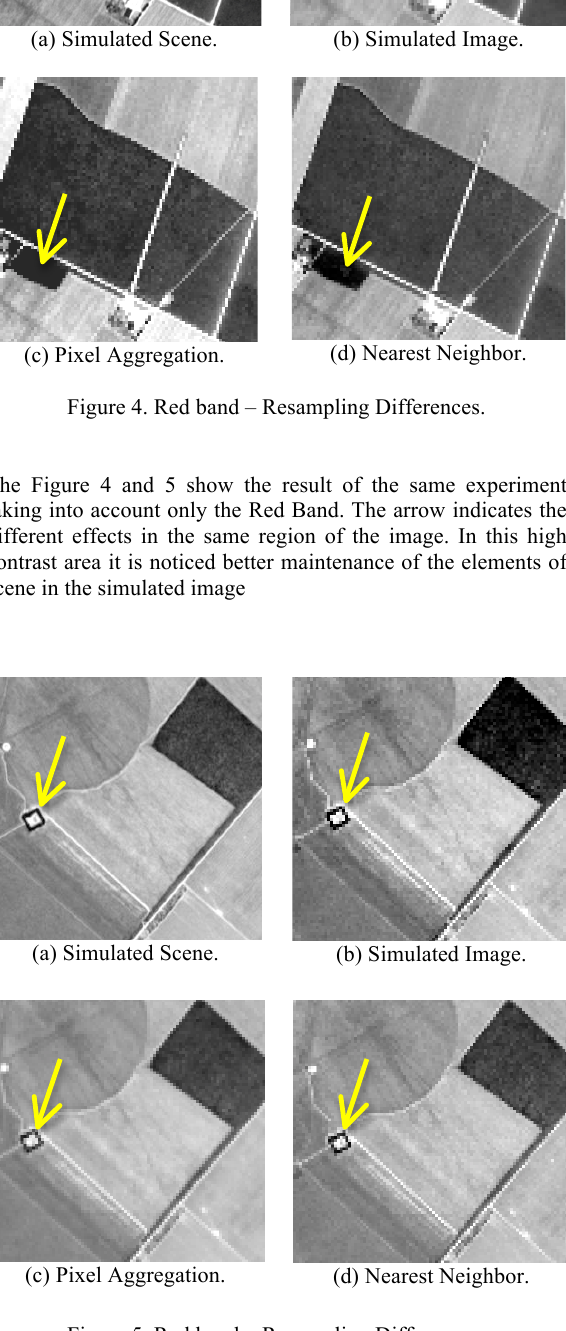
Figure 5. Red band – Resampling Differences.